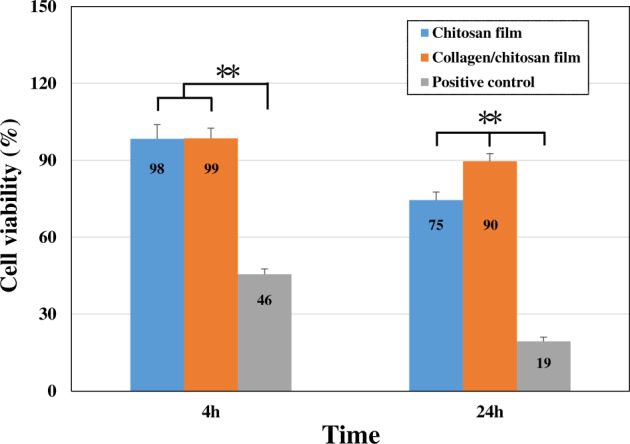
The percent cell viability of PC12 cells cultured for 4 and 24 h. (**: P < 0.01)